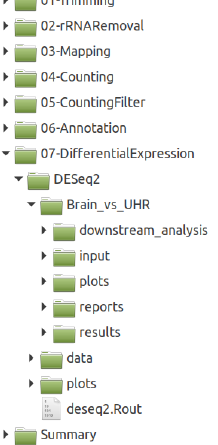
Figure 2. Structure of the result folder. Essential results for each step of the pipeline can be found easily. The DESeq2 output folder comprises general results and statistics for all samples as well as